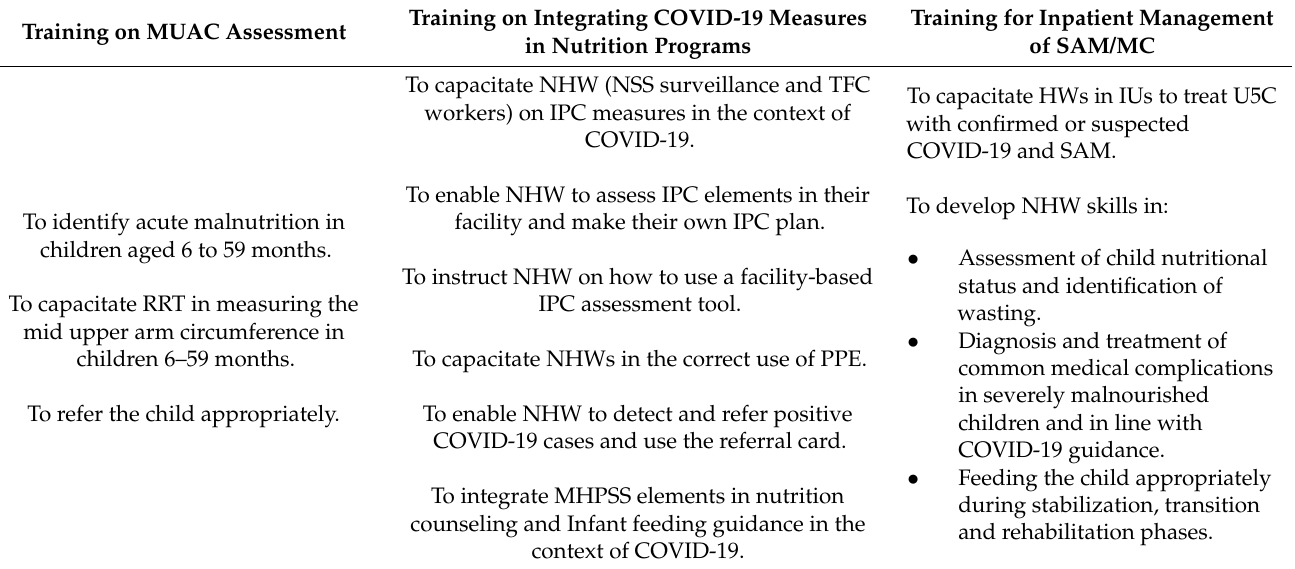
Table 4. Capacity building program within the programmatic adaptation in Yemen. Training on MUAC